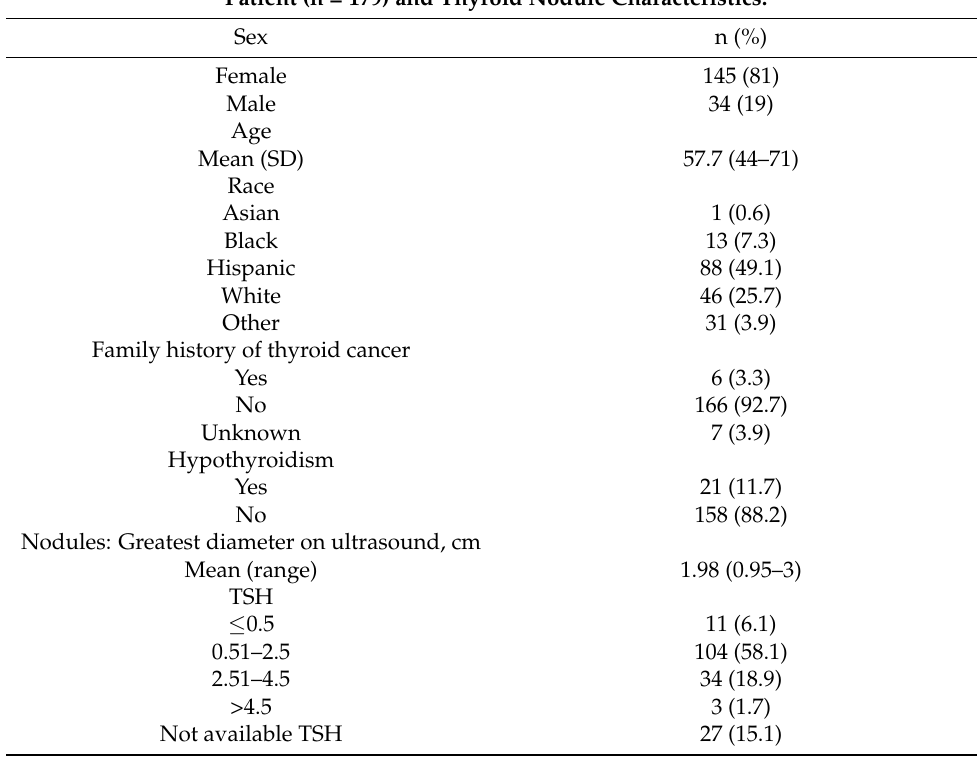
Table 1. Patient’s demographics. Patient (n = 179) and Thyroid Nodule